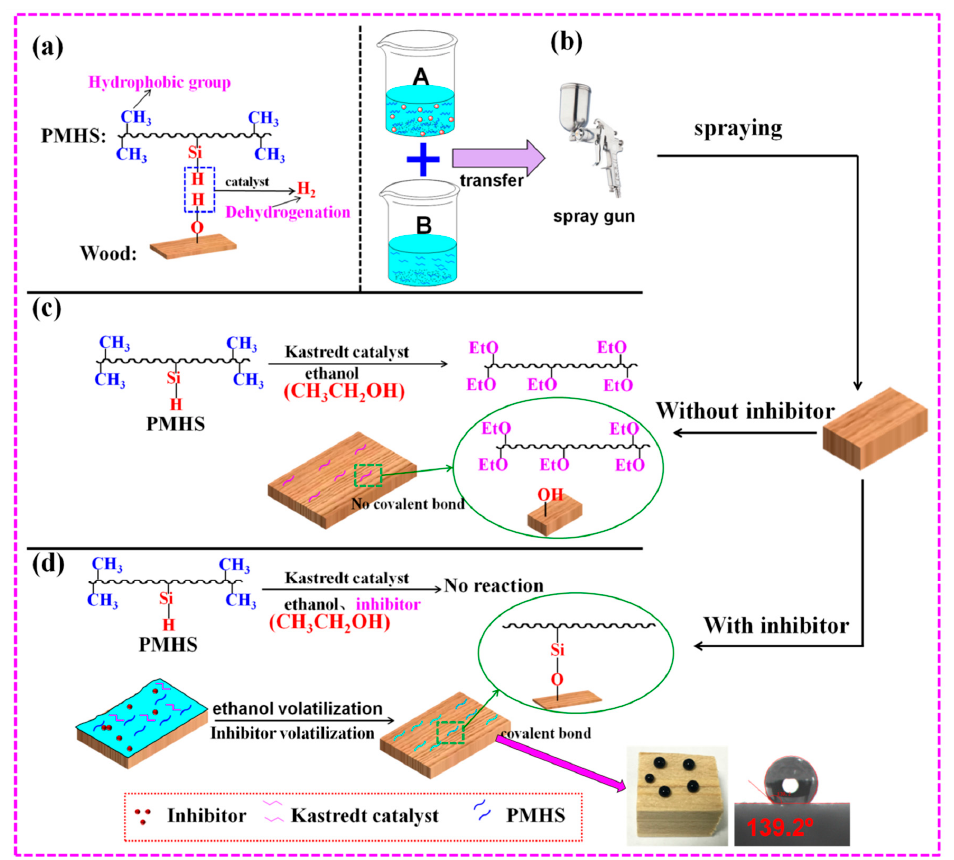
Figure 2. Schematic representation of preparation of hydrophobic wood samples: ( a ) the reaction between PMHS and wood, ( b ) mixing of modified solution, ( c ) without inhibitor, ( d ) with inhibitor. Polymers 2021 , 13 , x FOR PEER REVIEW